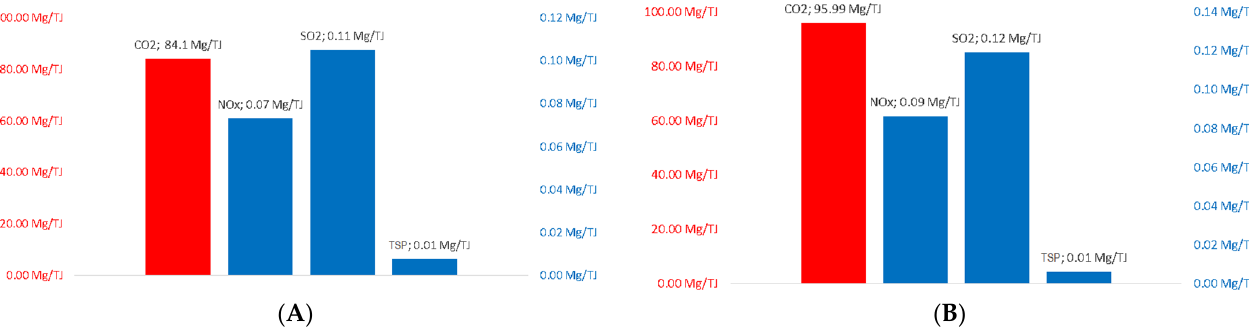
Figure 4. Comparison of absolute values of emissions in GZM and Warsaw. ( A ) Emissions in GZM: absolute values. ( B ) Emissions in Warsaw: absolute values.